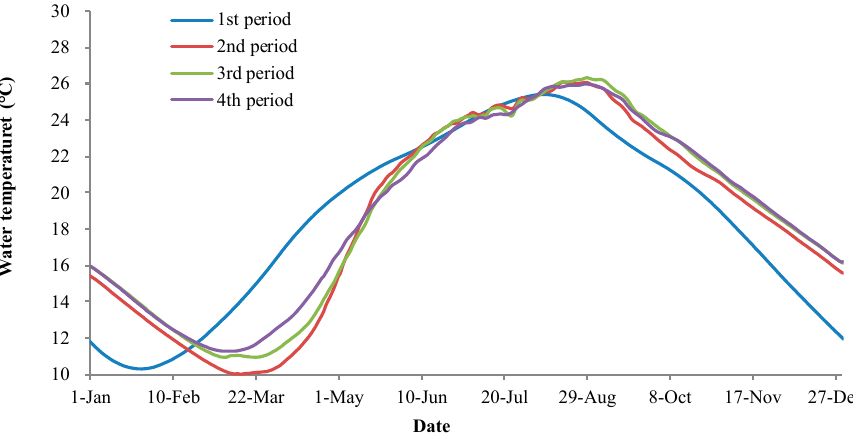
Figure 7. The discharge water temperature of TGD in each construction period.